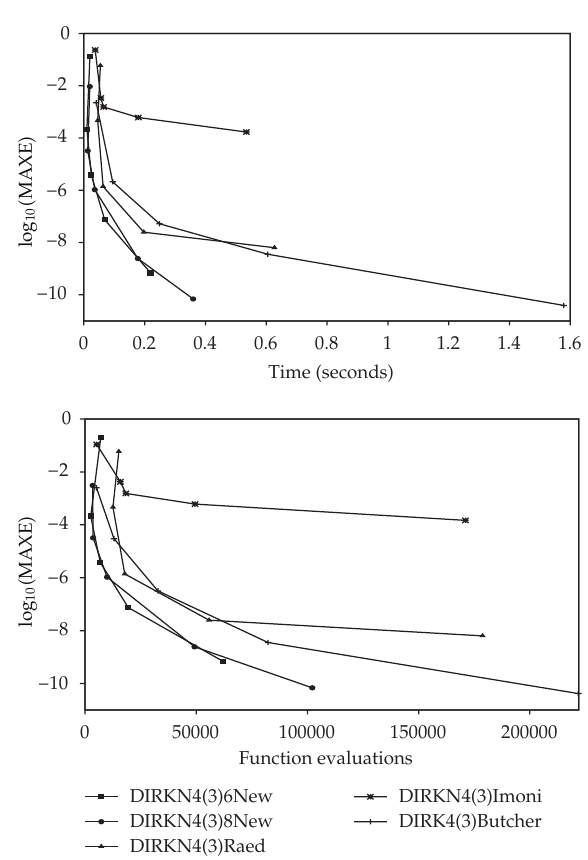
Figure 8: E ffi ciency curves for Problem